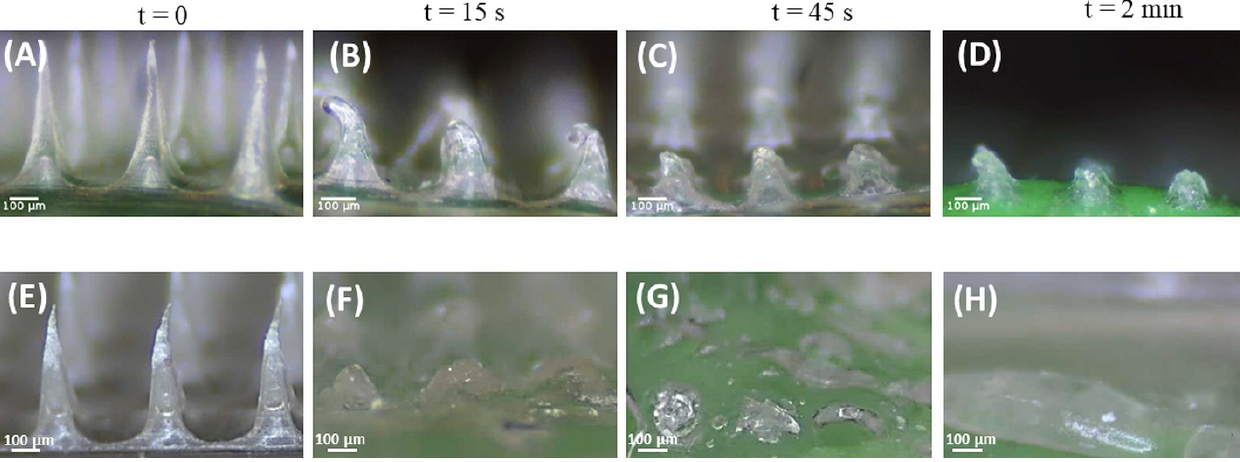
Figure 9. Ex-vivo and in vitro dissolution studies of NP-MNs: Representative images of NP-MNs before ( A , E ) and after dissolution in ex vivo chicken for 15 ( B ), 45 ( C ), and 120 s ( D ) and agarose gel after 15 ( F ), 45 ( G ), and 120 s ( H ). Scale bar 100 μ m.